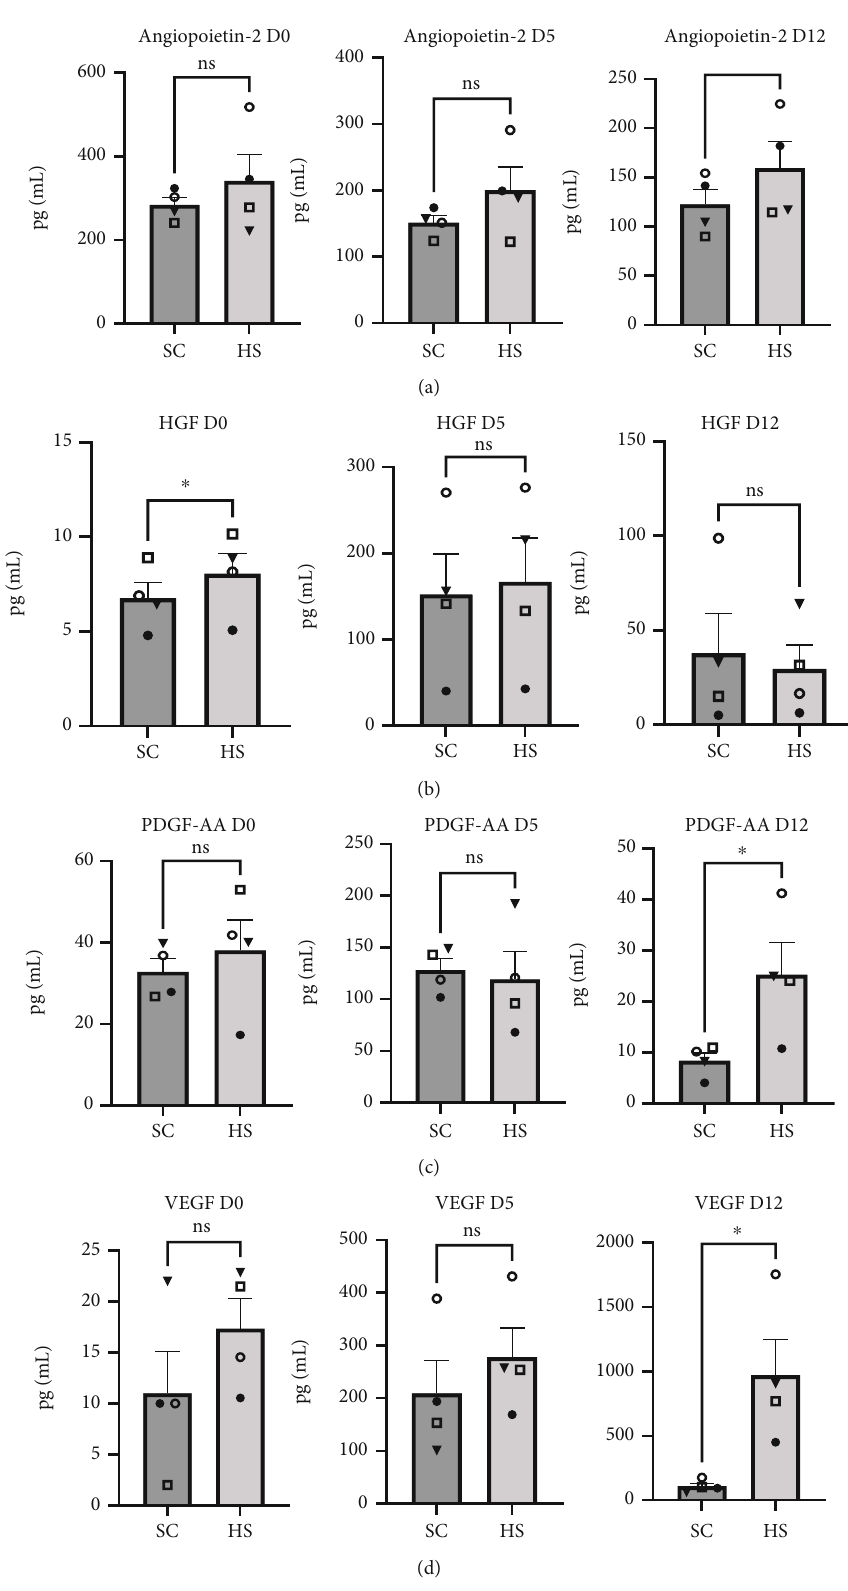
Figure 5: Growth factor concentrations in cell culture media with BMCs containing 15% sodium citrate (SC) or 100U/mL heparin sodium (HS) at day 0 (D0), day 5 (D5), and day 12 (D12): (a) angiopoeitin-2, (b) hepatocyte growth factor (HGF), (c) platelet-derived growth factor dimer AA (PDGF-AA), and (d) vascular endothelial growth factor (VEGF). Graphs display the population mean and standard error of the mean; shapes indicate donor-matched BMC products. ns: not signi fi cant, ∗ P < 0 : 05